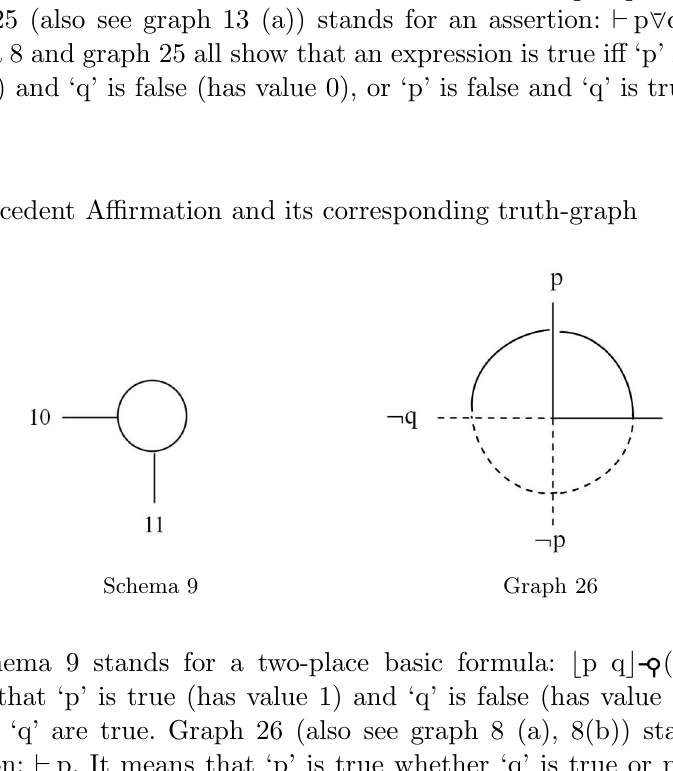
Schema 8 stands for a two-place basic formula: ⌊ p q ⌋ (pq), while graph 25 (also see graph 13 (a)) stands for an assertion: ⊢ p - ∨ q. In short,